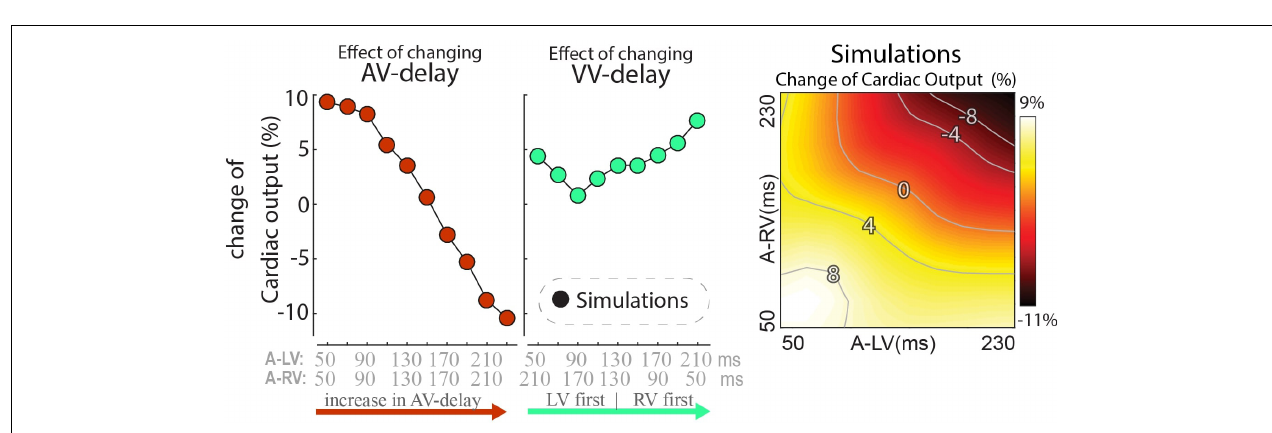
FIGURE 4 | Changes in contractile response as a result of changes in pacing delays in experiments and simulations. Percentile change from baseline of LV dP/dt max (top) and RV dP/dt max (bottom). The left rows depict the same AV and VV delay settings as in Figure 3 are shown. Heat maps for both the experiment (3rd column) and simulations (4th column). Diamonds: Canine measurements (Mean (standard error of the mean) of six dogs; Circles: Simulation output.